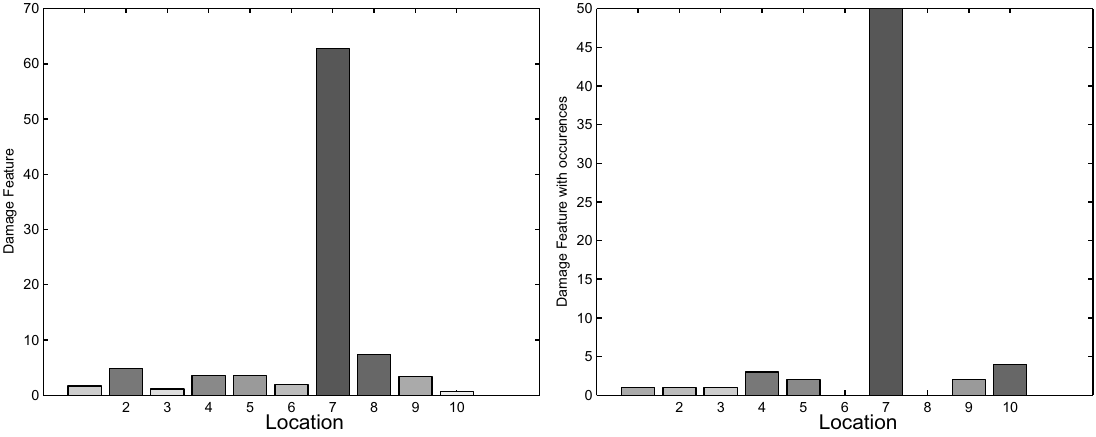
Fig. 40. Damage feature without and with occurrences for damaged structure and constant loading conditions with frequency